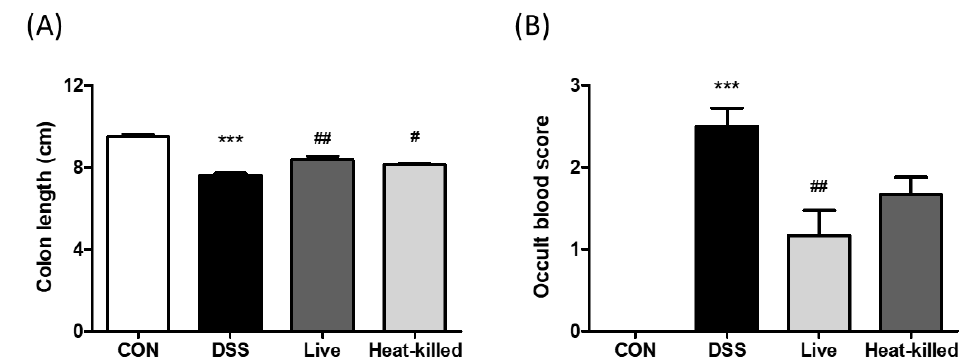
Figure 2. Oral administration of L. paracasei PS23 ameliorates shortened colon length and intestinal bleeding in DSS-induced colitis mice. At end of the experiment, the colon tissues were removed to measure the colon length ( A ). Fecal occult blood scores were also tested ( B ). Data are presented as mean ± SD. *** p < 0.001 versus the CON group, and # p < 0.05, and ## p < 0.01 versus the DSS group.